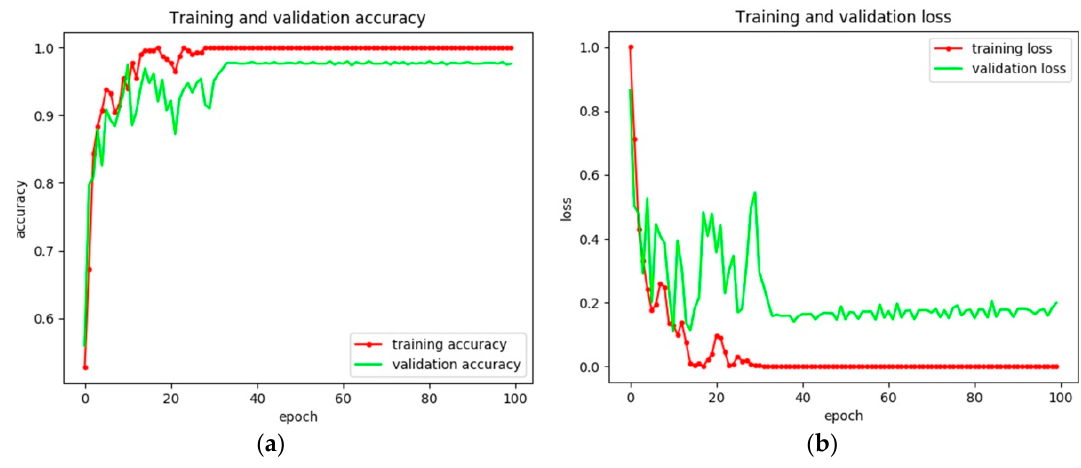
Figure 8. Experimental results of the ship classification model based on VGG16 via transfer learning. ( a ) Training and validation accuracy and ( b ) training and validation loss.